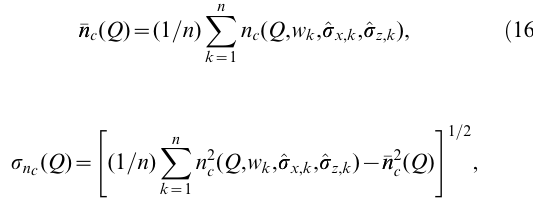
Afferent Mean firing rate (Hz)